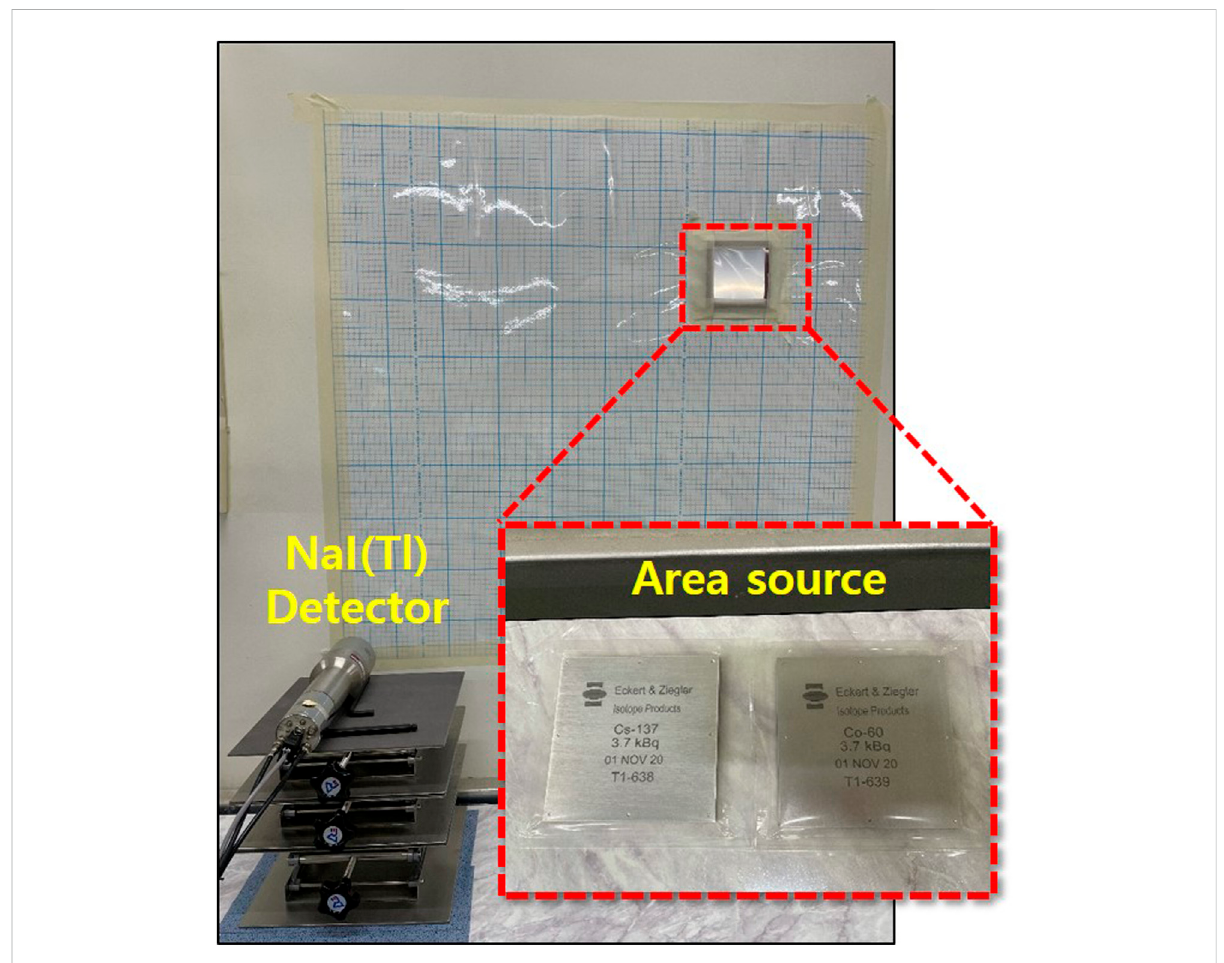
FIGURE 3 Arrangement of the detector and source on a wall for the experiment and the sources used in the